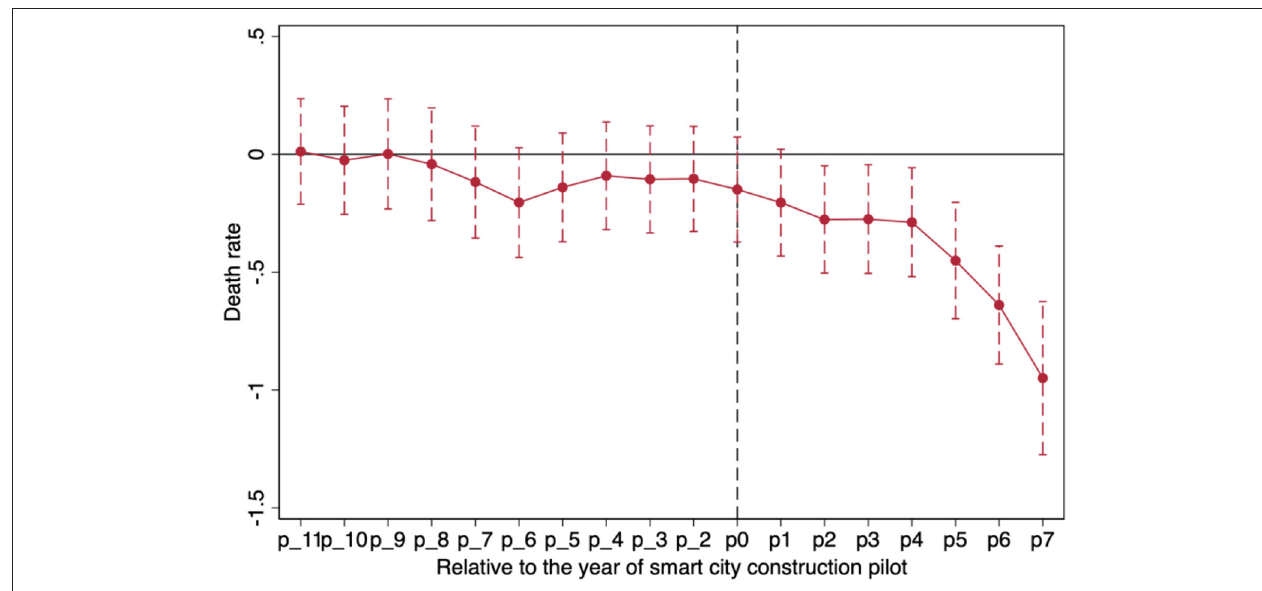
FIGURE 3 | The result of dynamic effects (death rate).